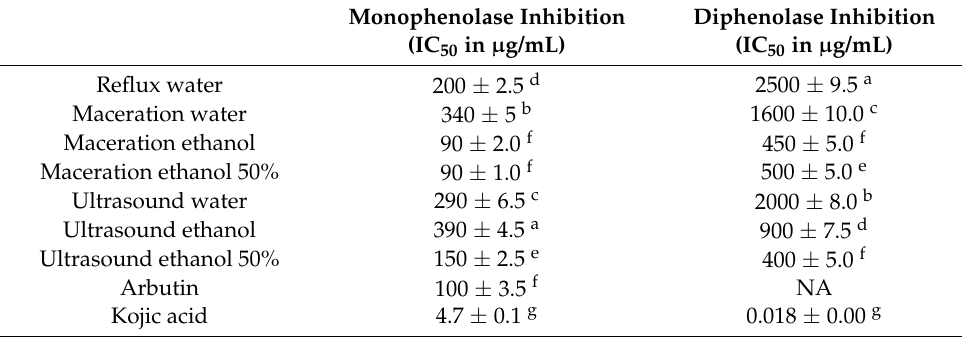
Table 5. Mean values of Anti-tyrosinase activities of A. unedo extracts. Monophenolase Inhibition (IC 50 in µ